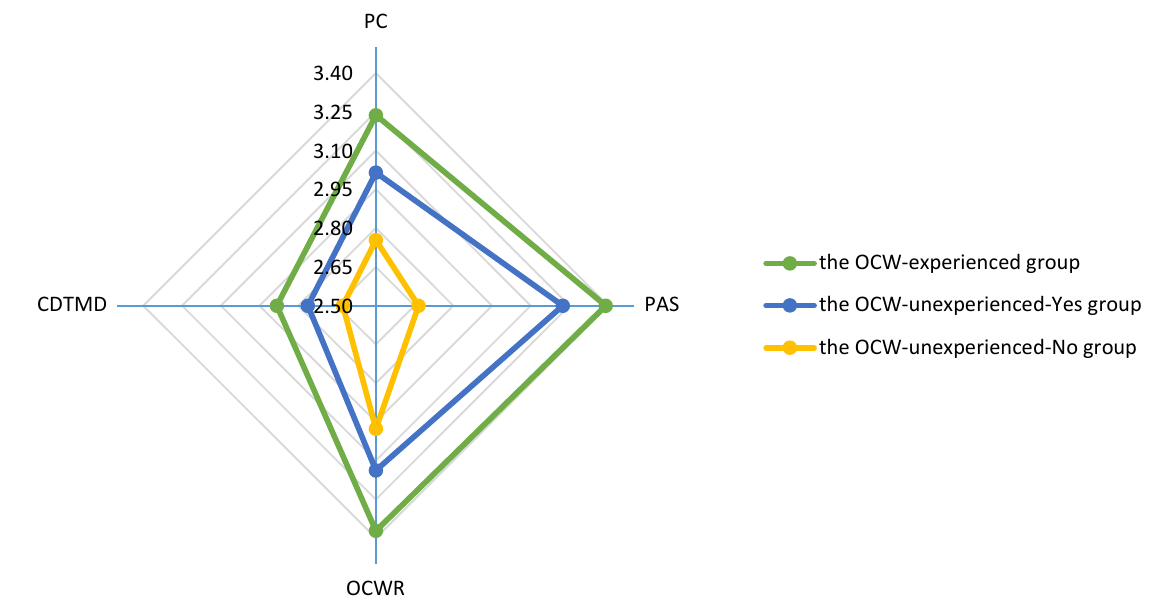
Radar Chart for the Mean Comparison of the Four Factors for the Three Faculty Groups